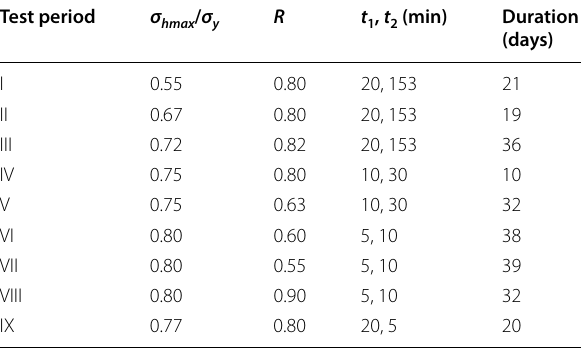
Table 2 Information on the test periods for pipe#1 Test period